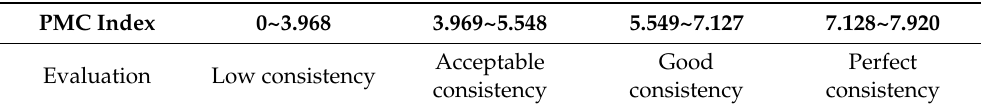
Table 5. Consistency